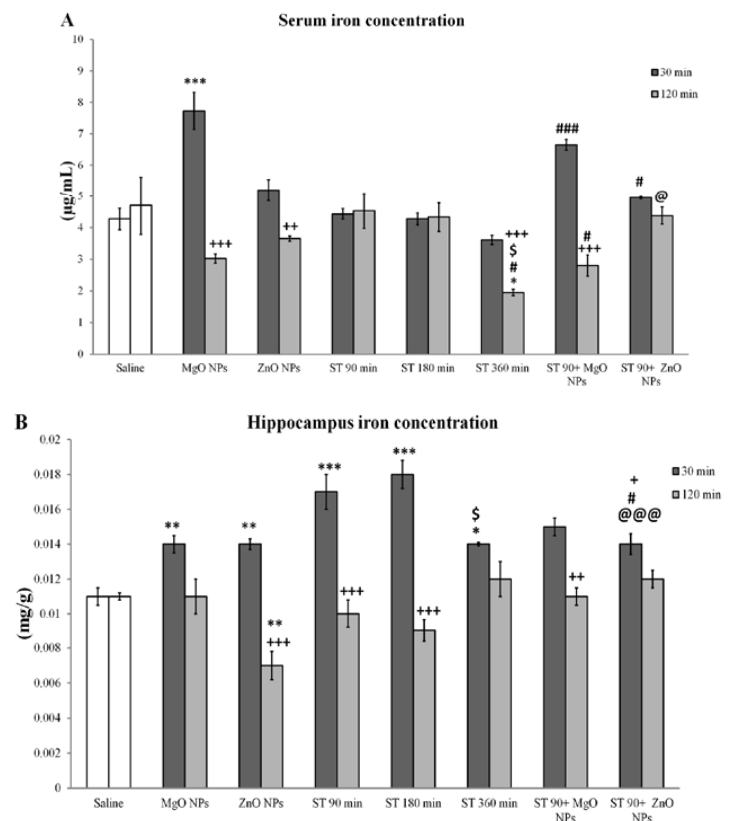
Fig.4. Assessment of Fe 2+/3+ concentration. *P<0.05, **P<0.01 and ***P<0.001 are in comparison with the control group at the same time (30 and 120 min). +P<0.05, ++P<0.01 and +++P<0.001 are differences between equal treatment groups in two different times (30 and 120 min). #P<0.05and ###P<0.001 are differences in comparison with ST 90 min groups at the same time (30 and 120 min). $P<0.05 is a significant difference in comparison with ST 180 min group at the same time (30 and 120 min). @P<0.05 and @@@P<0.001 are differences in comparison with ZnO NPs group at the same time. All bars are means ± standard error of the means.